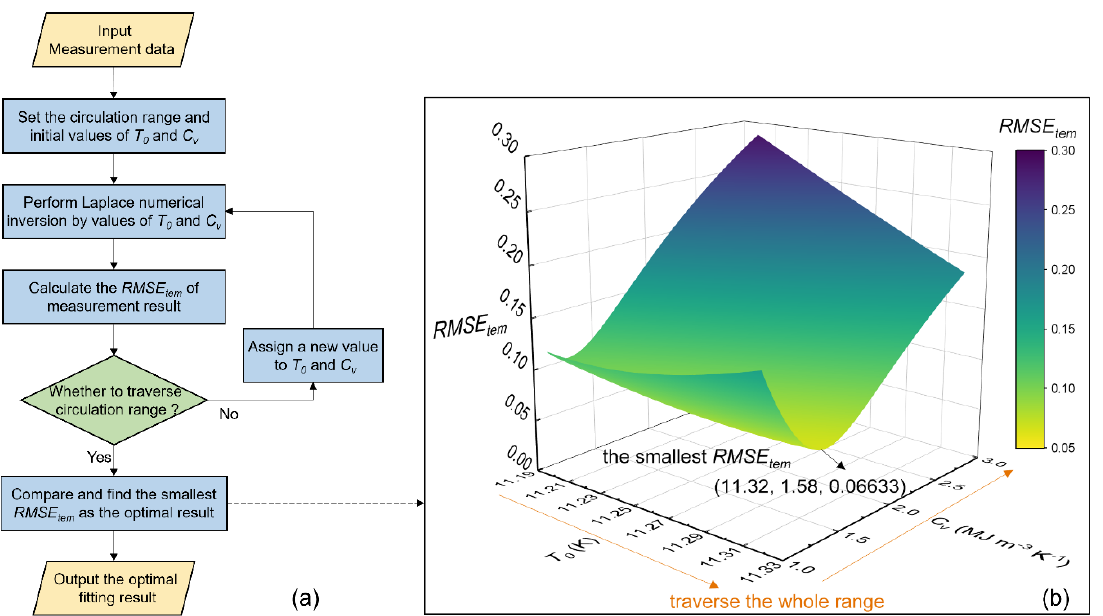
Figure 2. Principle of the fitting algorithm: ( a ) flow chart of the fitting algorithm and ( b ) minimization process of RMSE tem .